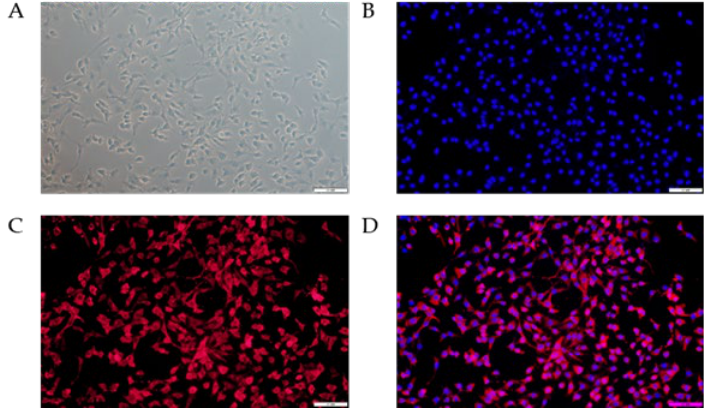
Figure 1. Phenotypic verification of bMECs by immunofluorescence with Cytokeratin 18 (200×). ( A ) Bright field. ( B ) DAPI staining. ( C ) Immunofluorescence with Cytokeratin 18 labeled with Cy3. ( D ) Merge of B and C.